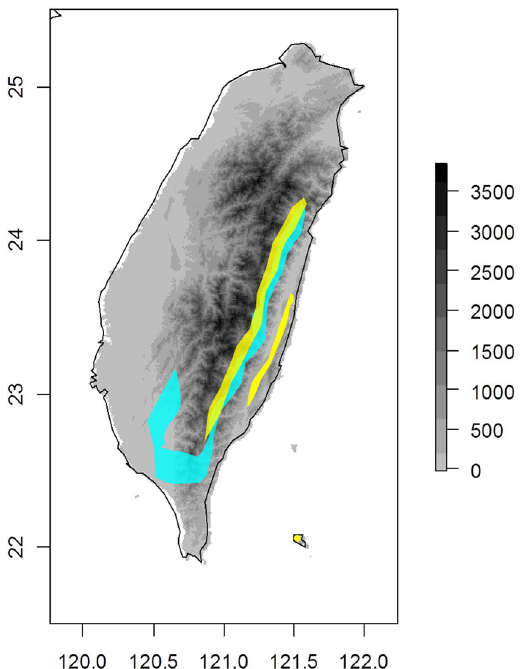
Figure 1. Distribution range of S . playfairii (light blue) and S . tashiroi (yellow) in Taiwan. Exact distribution of specimen records is shown in Fig. 5. Despite overlapping distribution ranges in the eastern Taiwan, sympatric populations were found in the southeastern Taiwan only. The map was constructed using the packages maptools 69 implemented in